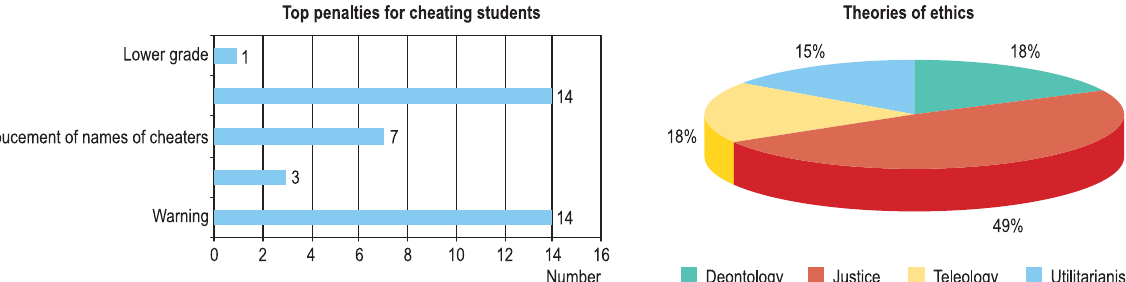
Fig. 5. Penalties for cheating students ( on the left ) and theories of ethics selected by the students ( on the right )